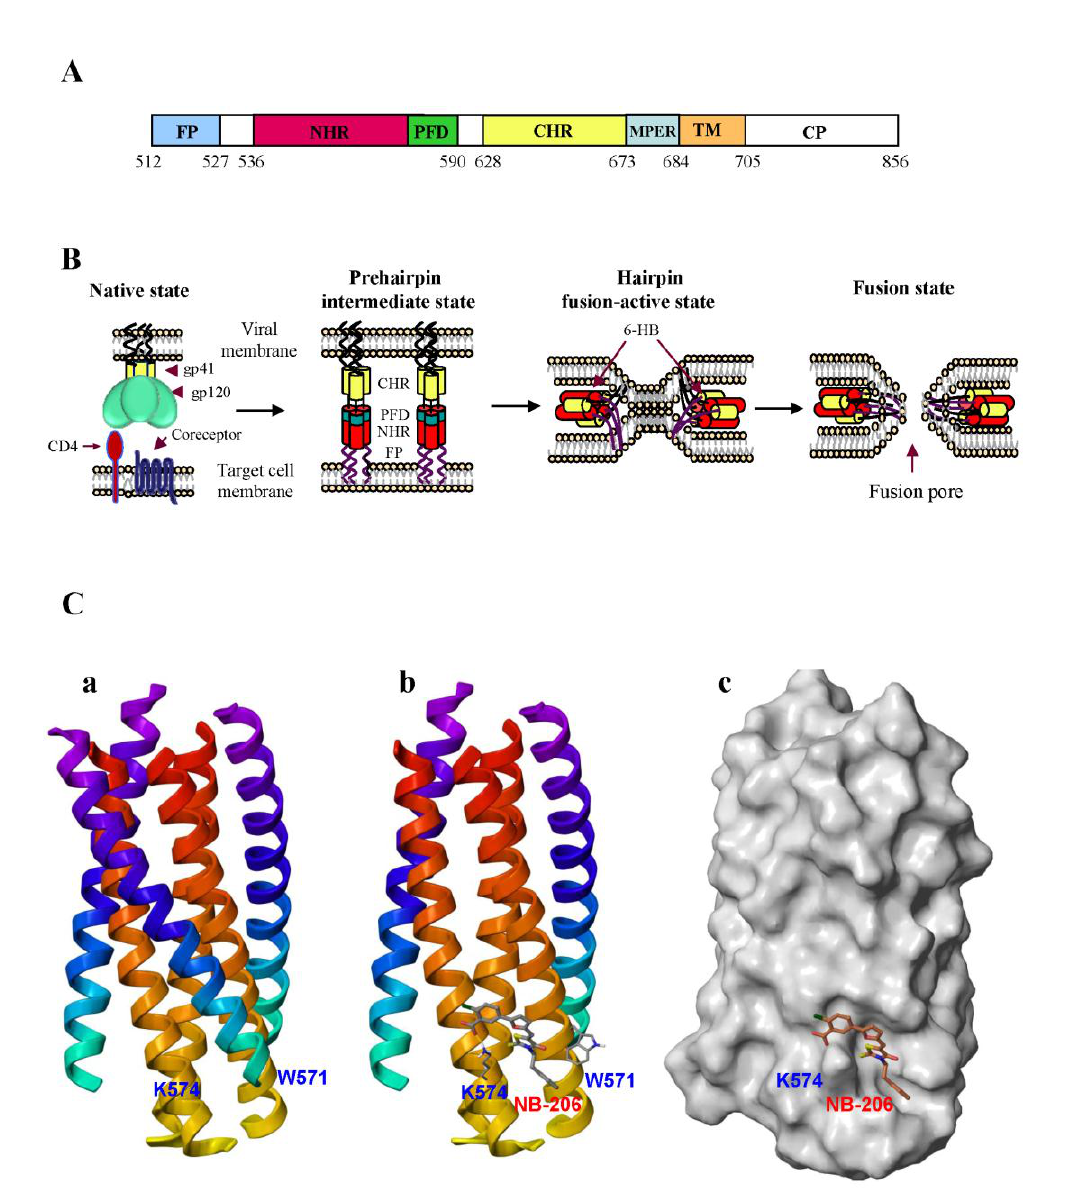
membrane fusion. Fusion of the HIV-1 envelope and target cell membrane is initiated by binding of the viral Env surface subunit gp120 to the cellular CD4 and then to a coreceptor (CCR5 or CXCR4) on the target cell. The Env transmembrane subunit gp41 changes conformation by inserting the FP into the target cell membrane and forming 6-HB between the viral gp41 NHR and CHR regions, bringing the viral and target cell membranes into close proximity for fusion ( C) The crystal structure of the gp41 6-HB and docking of NB-206 in the gp41 hydrophobic pocket cavity. ( a ) Side view of the gp41 6-HB core structure formed by the N-peptide, N36, and C-peptide, C34. ( b ) Stereo view of NB-206 docked in the hydrophobic pocket showing the possible interactions with the neighboring hydrophobic and charged residue K574. ( c ) Surface representation of the gp41 core (with one C-peptide removed) with bound ligand NB-206, which docks inside the cavity with the negatively charged COOH group pointing towards the positively charged side chain of